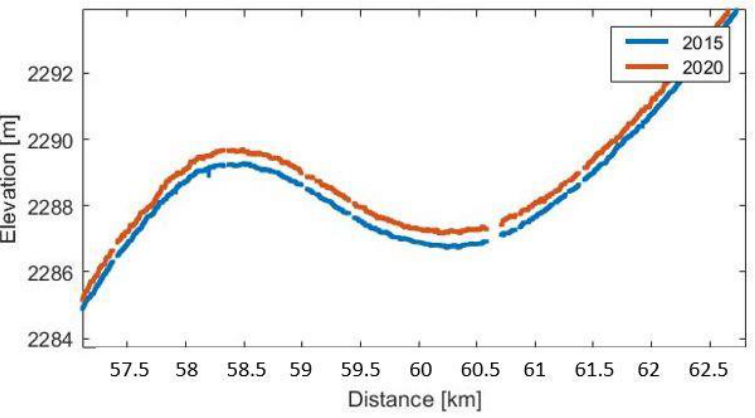
Figure 7. Comparison of a selected part of the profile from 2015 and 2020.